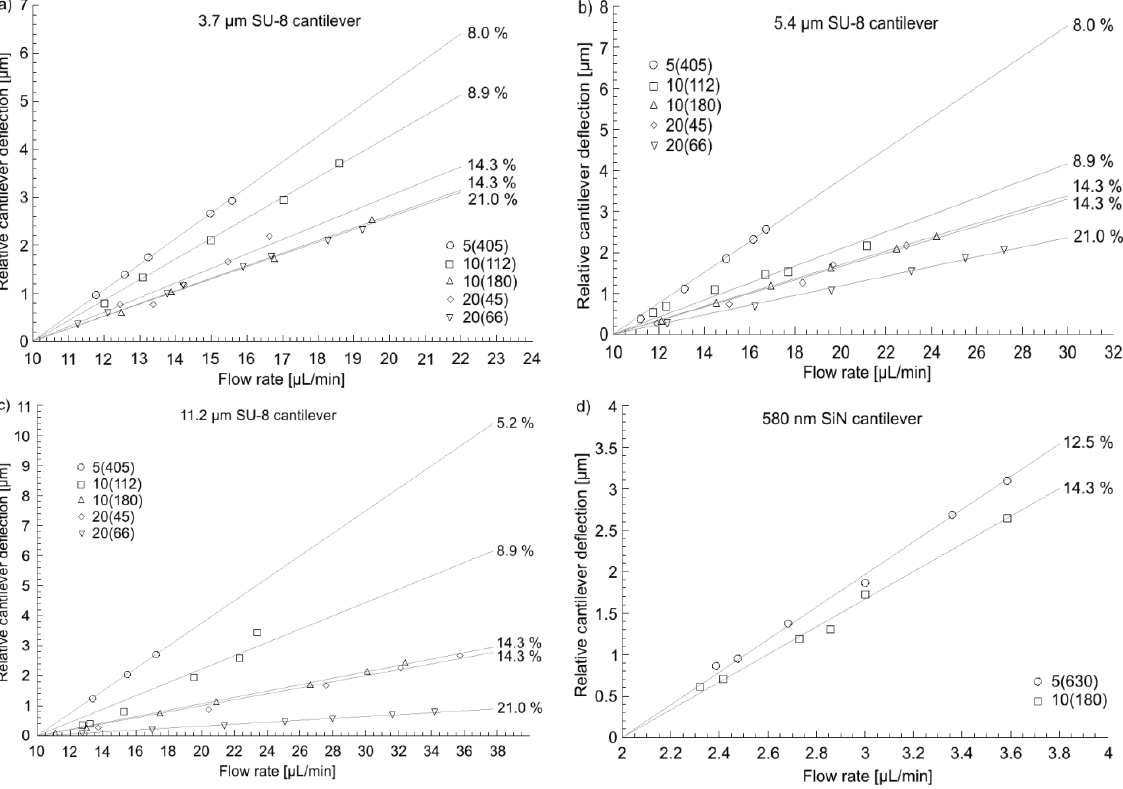
Figure 7. Relative cantilever deflection as a function of flow rate for various sensor designs: ( a ) 3.7 µm thick SU-8 cantilevers. ( b ) 5.4 µm thick SU-8 cantilevers. ( c ) 11.2 µm thick SU-8 cantilevers. ( d ) 580 nm thick SiN cantilevers. The porosity p for the corresponding design is indicated (%). For design 5(405) in (c), p = 5.2% due reduced lithographic resolution for 11.2 µm thick